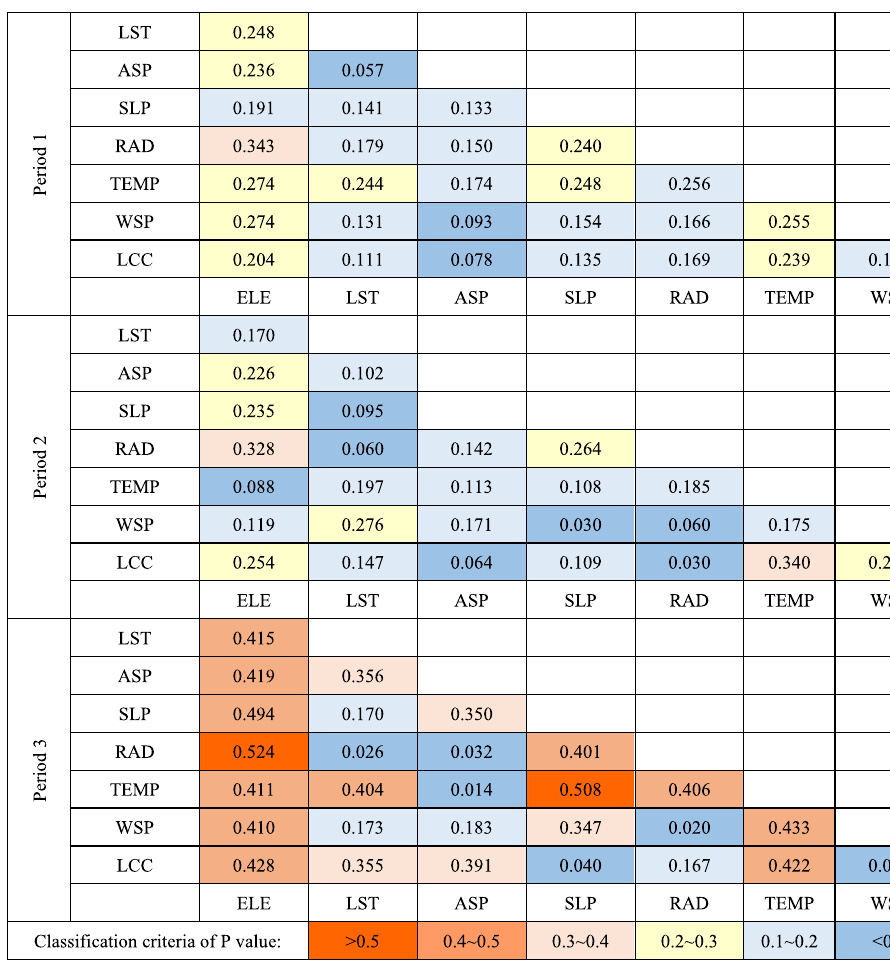
Table 4. Q values of the interaction between of snow-melting factors in three periods. The warm and cool colors are used to distinguish the Q and P values. The warmer the color is, the more important it is, and vice